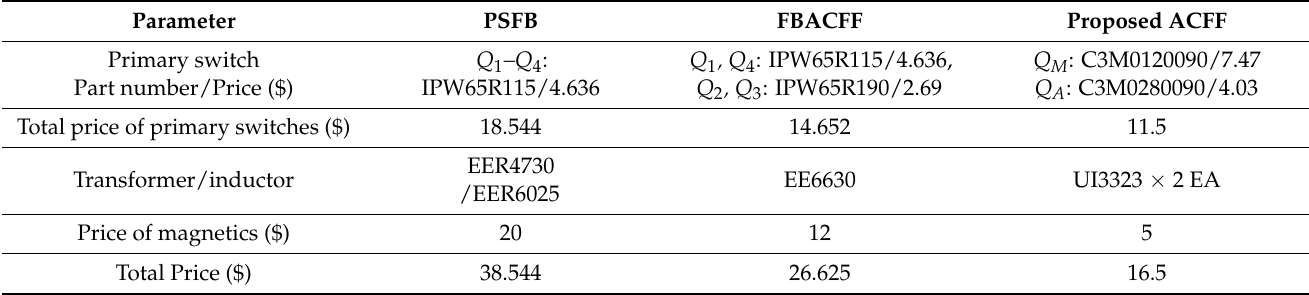
Table 3. Components and cost comparisons.